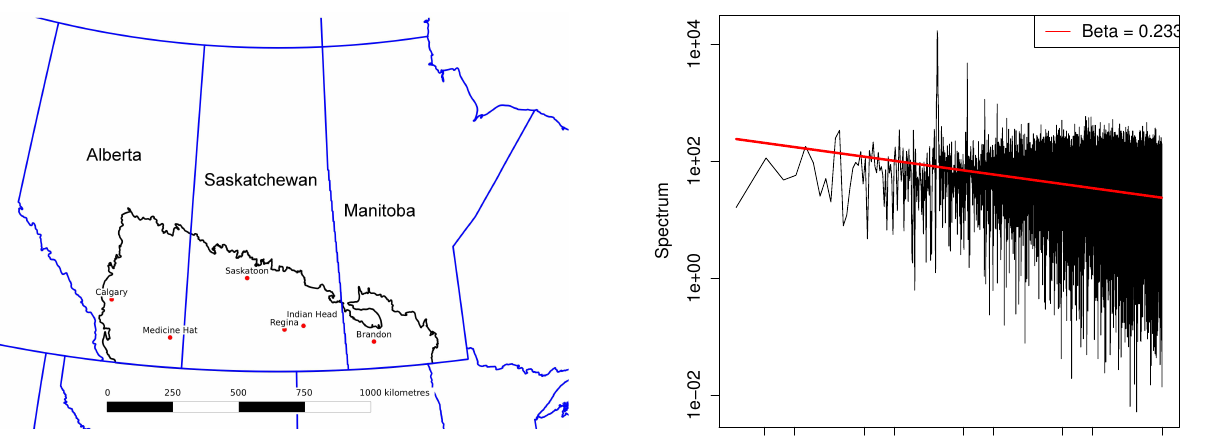
Fig. 1. Location of the study sites in Western Canada. The prairie ecoregion in Canada is outlined.